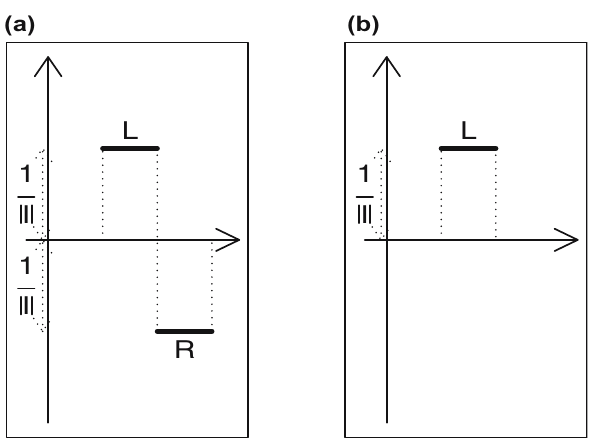
Figure 1: An illustration of the special atom of types 1 and 2 for = p 1 . ( a ) Type 1, ( b ) Type